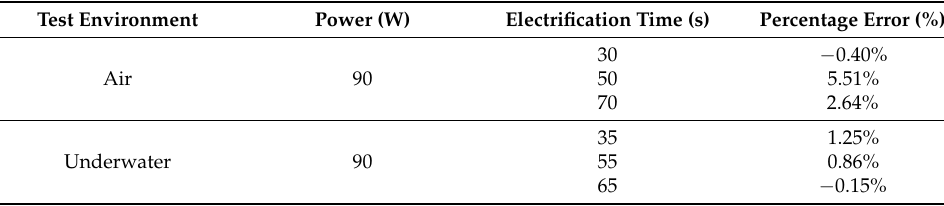
Table 3. Percentage error of